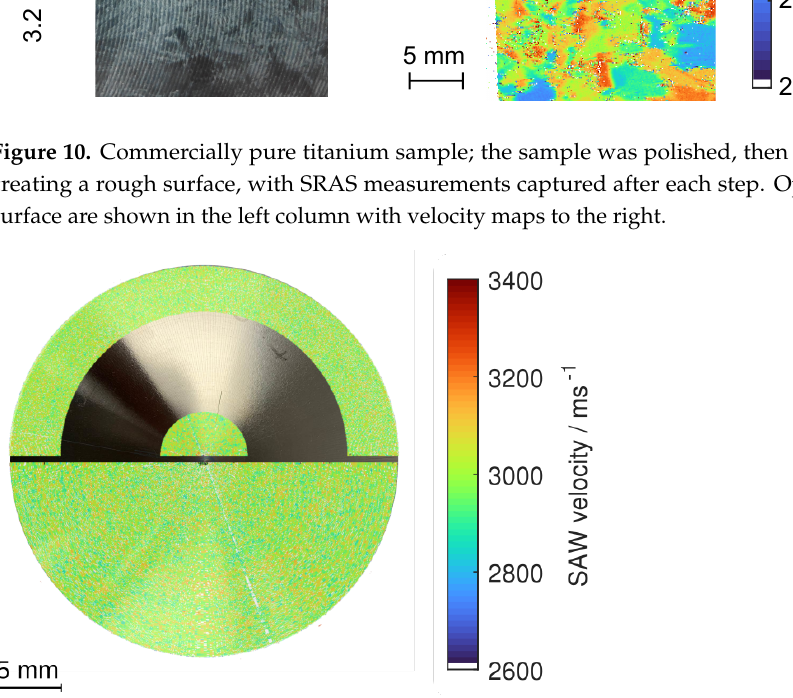
Figure 11. SRAS velocity map of machined Ti-6Al-4V billet, with surface roughness of R a ≈ 0.8 µ m. The lower half of the billet shows a velocity map captured at a fixed angular resolution, leading to an increasing pixel size towards the edge of the sample. In contrast, the velocity maps in the upper half maintain a constant pixel size. A cropped photograph of the sample is inset in the upper half to show the surface